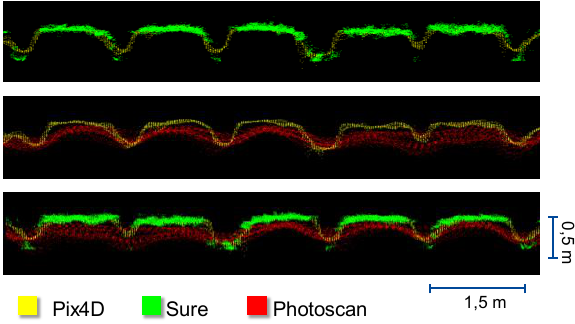
Figure 2. Comparison of 3D-point clouds of a winter wheat plot derived with different software packages